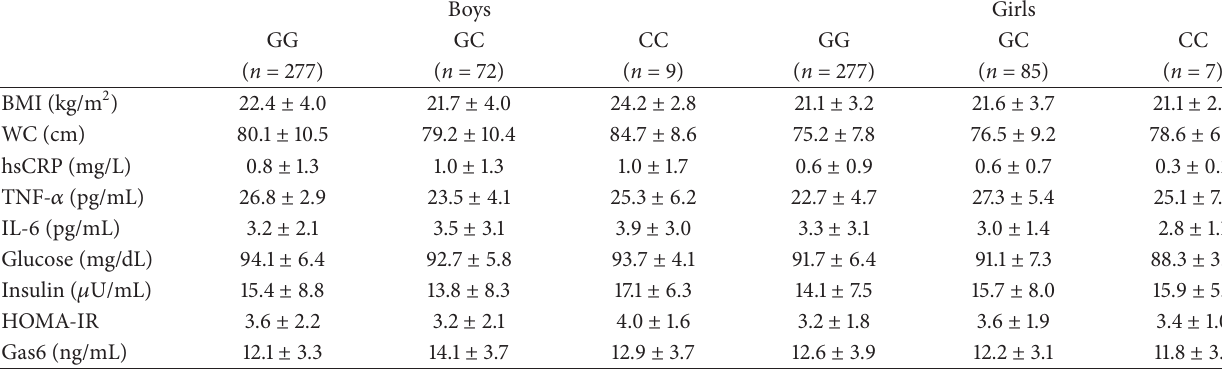
Table 1: Anthropometric and biochemical data with different GAS6 rs8191973 genotypes among boys and